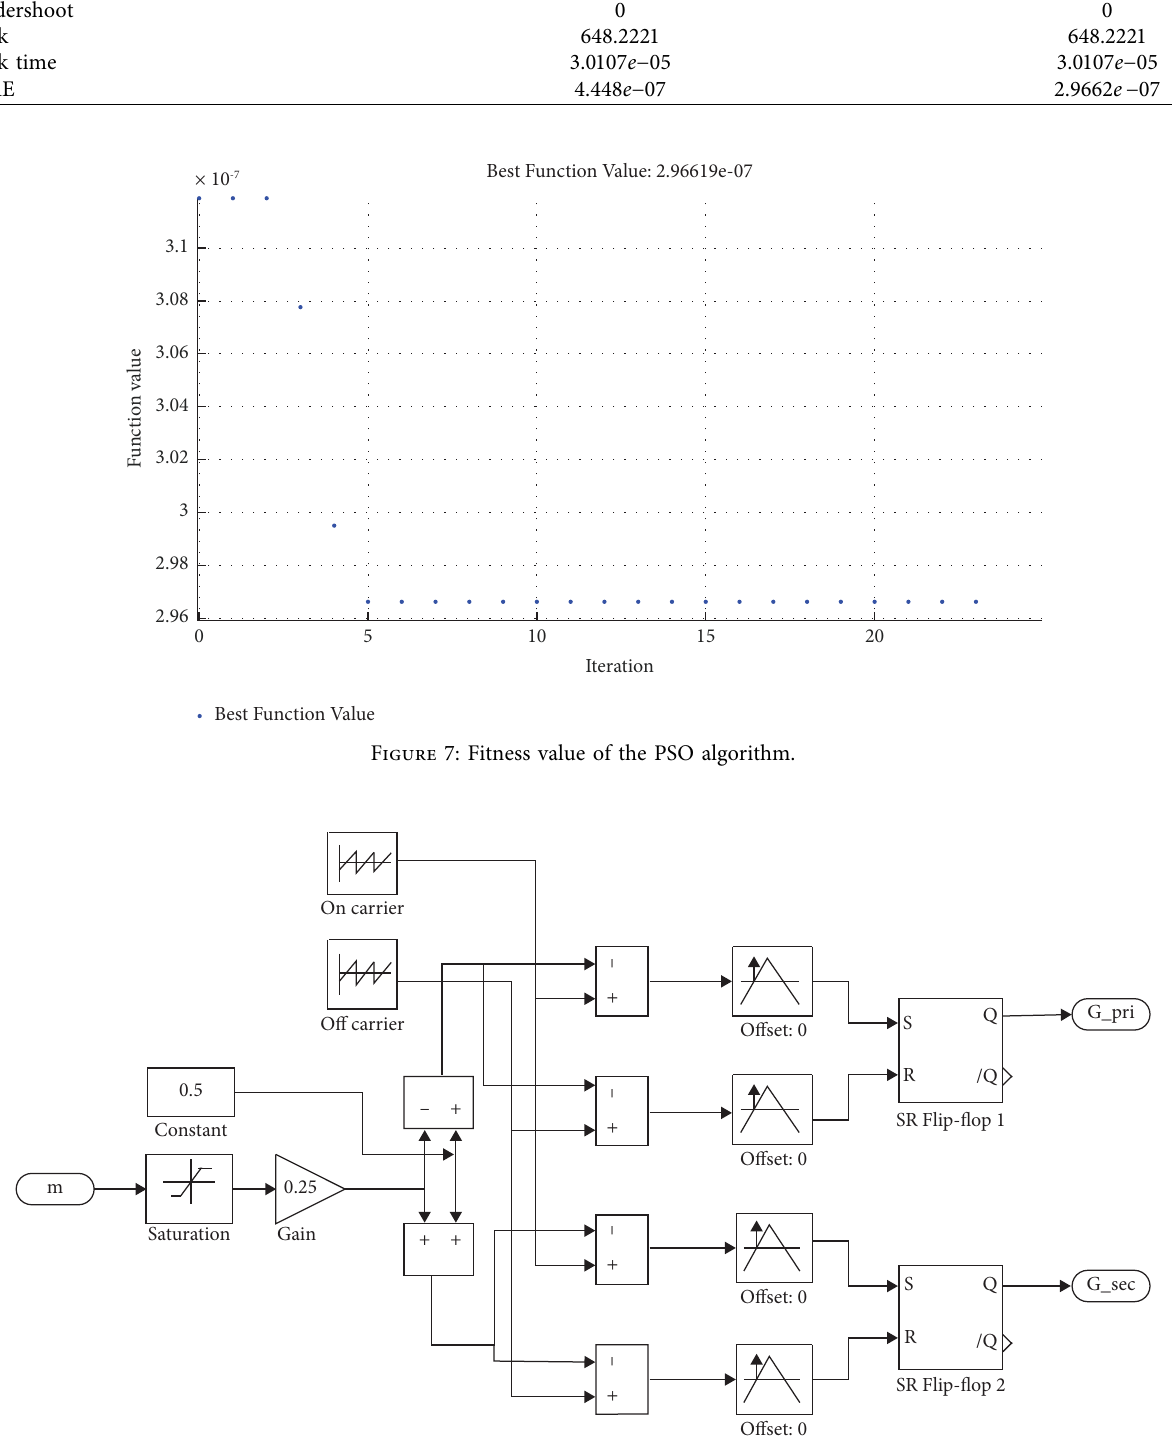
Figure 8: Phase shift PWM block